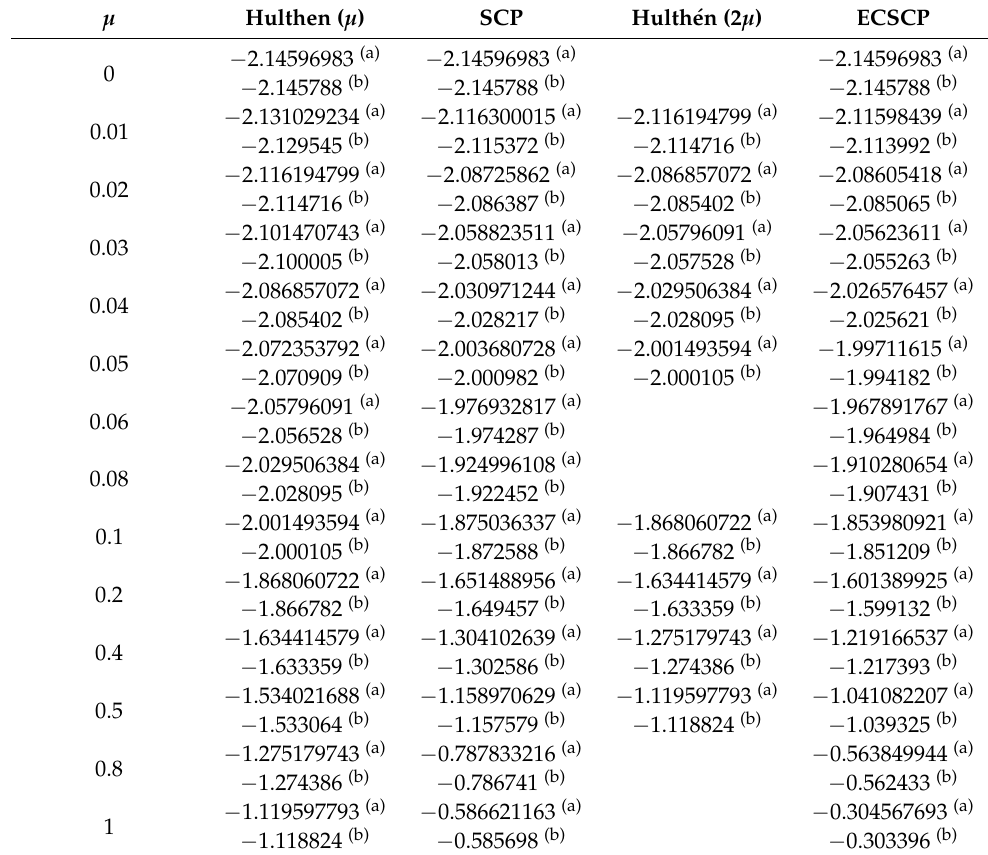
Table 5. Comparison between (a) LMM and (b) VMC for (1s2s) excited states of 1 S energies of